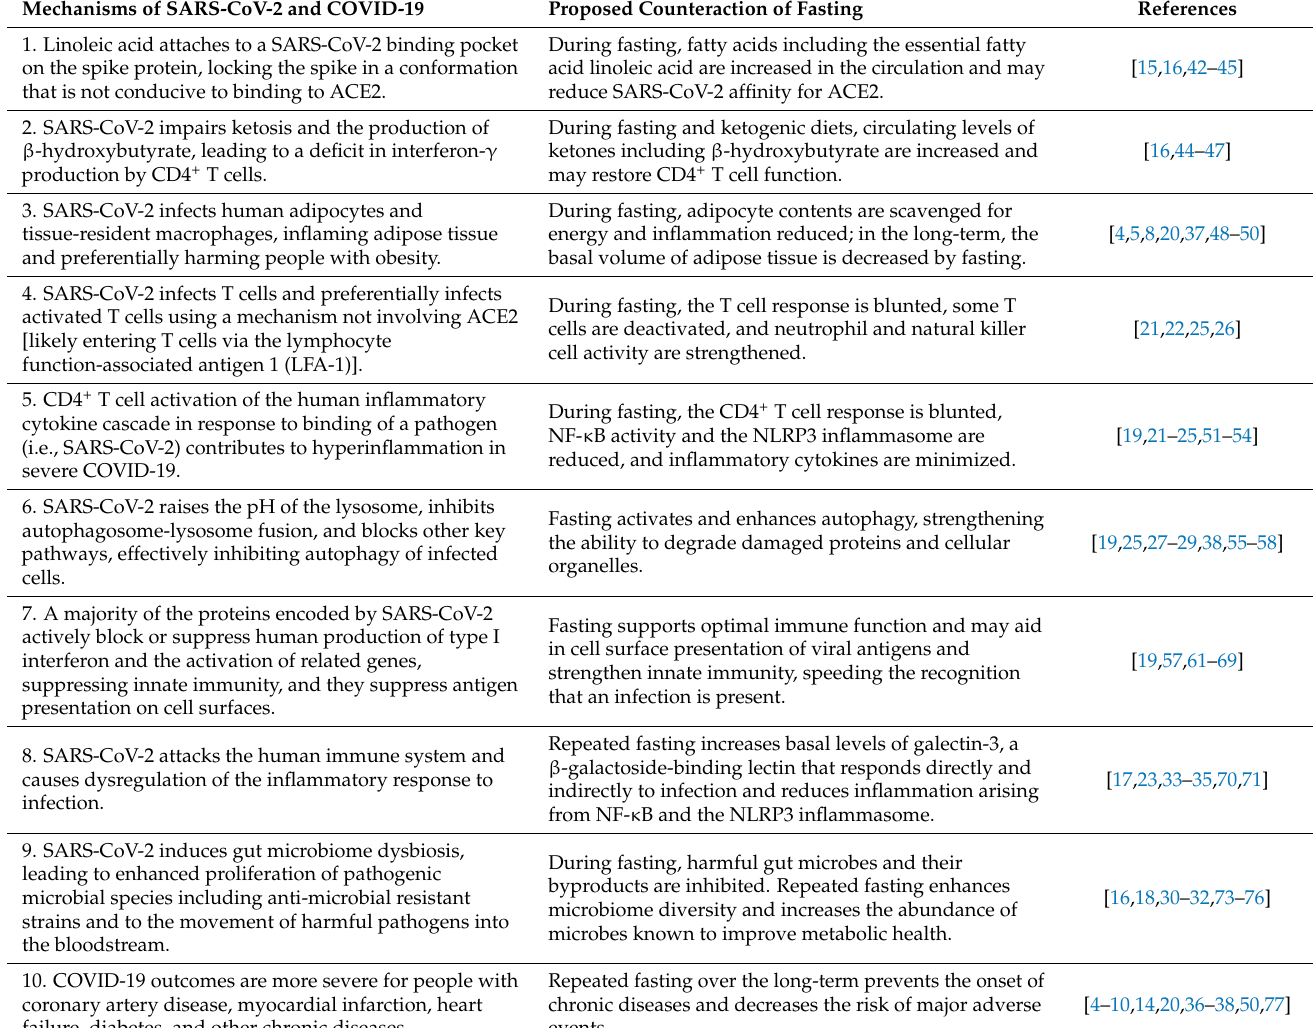
Table 1. Proposed mechanisms of intermittent fasting in preventing severe COVID-19